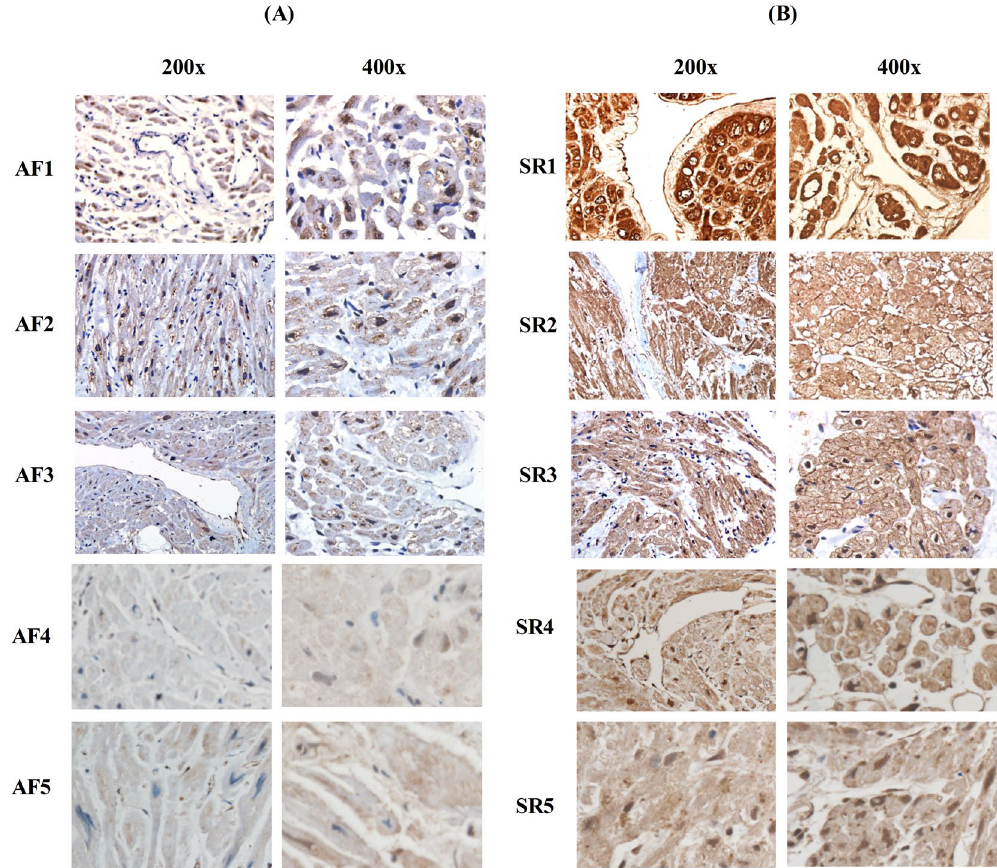
Figure 4. Expression of Ecrg4 is down-regulated in appendages of AF patients. Specimens of atrial appendage from right atrium were harvested from 5 RHD patients with persistent AF ( A , labeled AF1–5 on left panel) and 5 RHD patients with SR ( B , labeled SR1–5 on right panel) respectively. The specimen were fixed, microtomed, and proceeded for IHC using anti-Ecrg4 as primary antibody and goat anti-rabbit-HRP as secondary antibody per instructions in materials and methods. Representative images (with 200x magnification on the left side and 400x magnification on the right side of A and B respectively) showing a light brown staining of cardiomyocytes (low level of Ecrg4) in all 5 specimens of atrial appendages from patients with AF ( A , left panel) relative to a dark brown staining of cardiomyocytes (high level of Ecrg4) in all 5 specimens of atrial appendages from patients with SR ( B , right